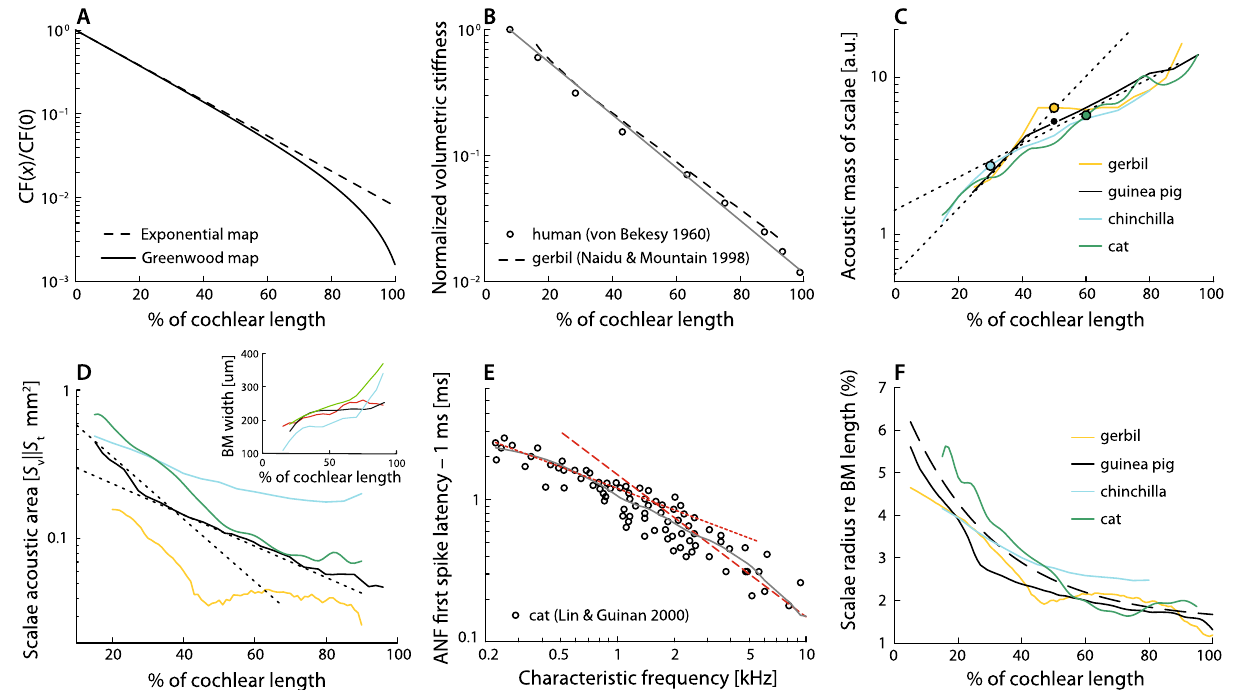
Figure 1. ( A ) Example tonotopic maps for the mammalian cochlea computed using Eq. (2) for the Greenwood 0.8 (solid line) and γ 0 (dashed; purely exponential). In many species, function with parameters γ = = the tonotopic map shows a pronounced downward bend in the apex. ( B ) Longitudinal variation of CP stiffness in human 9 and gerbil 25 . For comparison, the thin solid line shows the exponential map from panel m ( x ) , of the scalae fluids in four species (solid lines) A. ( C ) Estimated spatial variation of the acoustic mass, ¯ derived from published morphological data and arbitrarily scaled to emphasize the similarity of their spatial 2 ℓ dependence. For comparison, the dotted lines show the exponential curves e x /ℓ and e x / (i.e., the reciprocal of the exponential map in panel A and its square root, respectively). The open symbols indicate the approximate location of the apical-basal transition ( CF a b ) in each species 7,26 . ( D ) Effective acoustic cross-sectional areas of | S t ) ] as a function of location in various species. For comparison, the dotted lines show the scalae [ S v S t /( S v + 2 ℓ the exponential curves e − x /ℓ and e − x / (i.e., the exponential map in panel A and its square root, respectively). The inset shows the estimated BM widths employed to compute the acoustic mass of the scalae in panel C. ( E ) Wave-front delay in the apex of the cat cochlea, as estimated by subtracting 1 ms from the ANF first-spike latency of the response to acoustic clicks (Fig. 6A of Ref. 27). (Two anomalous data points with delay close to zero are not shown.) The gray line shows the loess trend line, while the dashed and dotted red lines are curves 1 / 2 ( x ) with slopes matching 1 / CF ( x ) and 1 / CF , respectively. ( F ) Variation of the radius ( h ) of the scalae along the cochlea in several species, normalized to the cochlea length. The radius was estimated by fitting a circle to the total area of the scalae in all species but the cat, where the radius was estimated as the average of the scala 0.0475 e 0.015 x / 2 ℓ vestibuli and scala tympani height. The dashed line represents the equation h ( x )/ L − = +